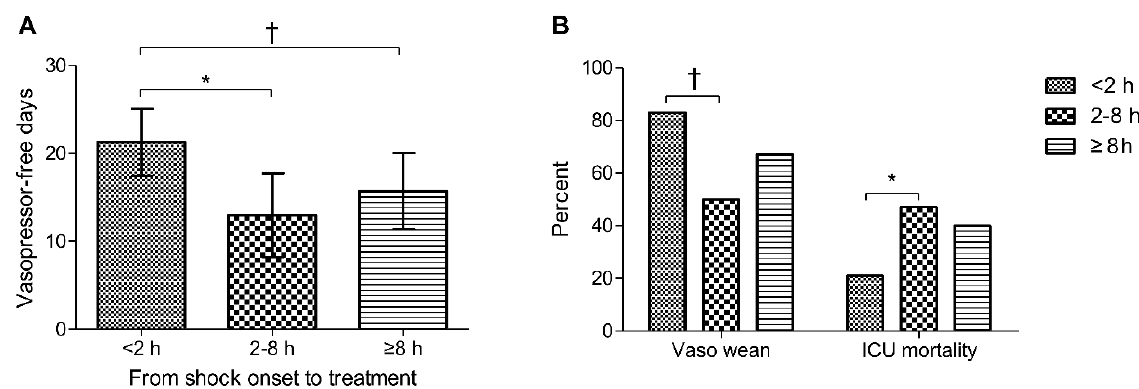
Figure 2. ( A ) Vasopressor-free days at day 28, ( B ) vasopressor weaning, and ICU mortality according to timing of the vitamin C protocol. Error bars indicate the 95% confidence intervals. ICU: intensive care unit. * p < 0.05, † p < 0.01 when the groups were compared by the Mann–Whitney U test or Student’s t -test for continuous variables and by the chi-squared test or Fisher’s exact test for categorical variables.